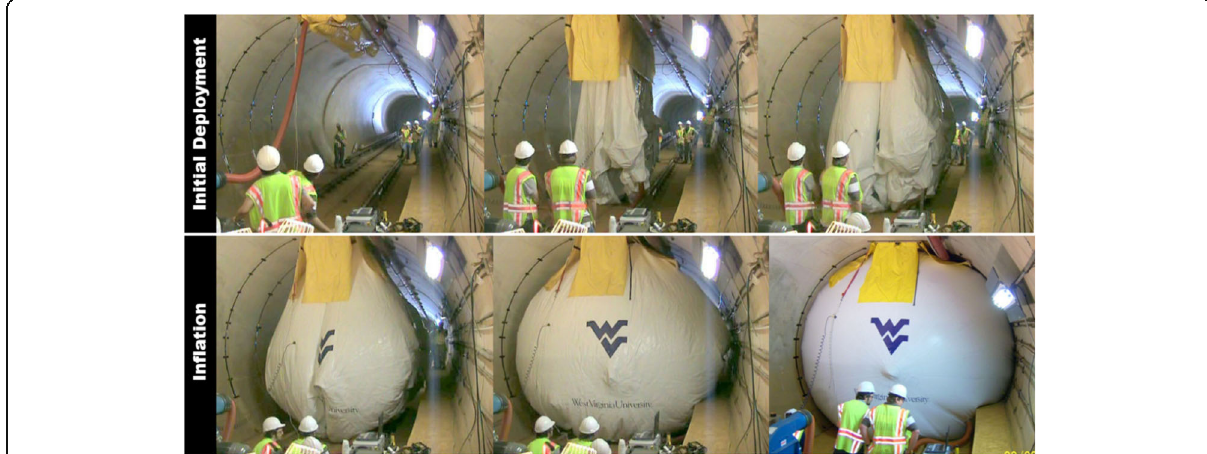
Fig. 3 Phase 1, full-scale testing, proof of concept in actual railway tail tunnel